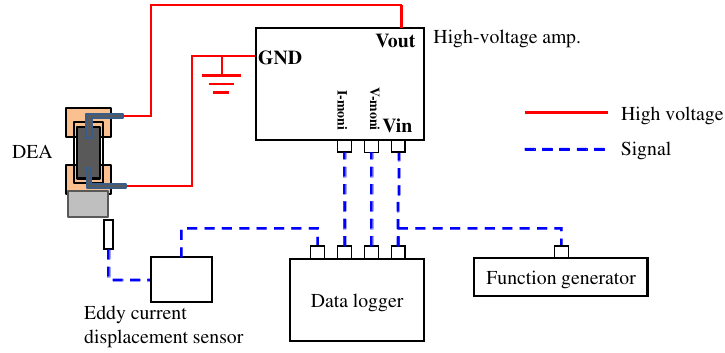
Figure 9. Schematic of the wiring of the experimental